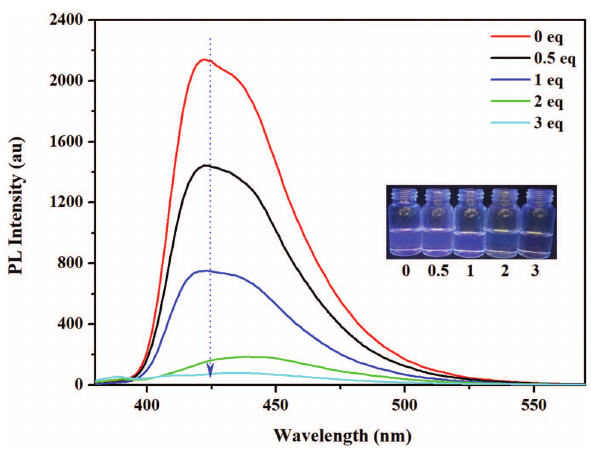
Figure 1: PL spectra of 1,8-bis( p -tolylthio)pyrene in DCM in the pres- ence of different content of m -chloroperoxybenzoic acid from 0 to 3 eq. For PL measurement, 1,8-bis( p -tolylthio)pyrene concentration: 10 − 5 M, excitation wavelength: 365 nm.